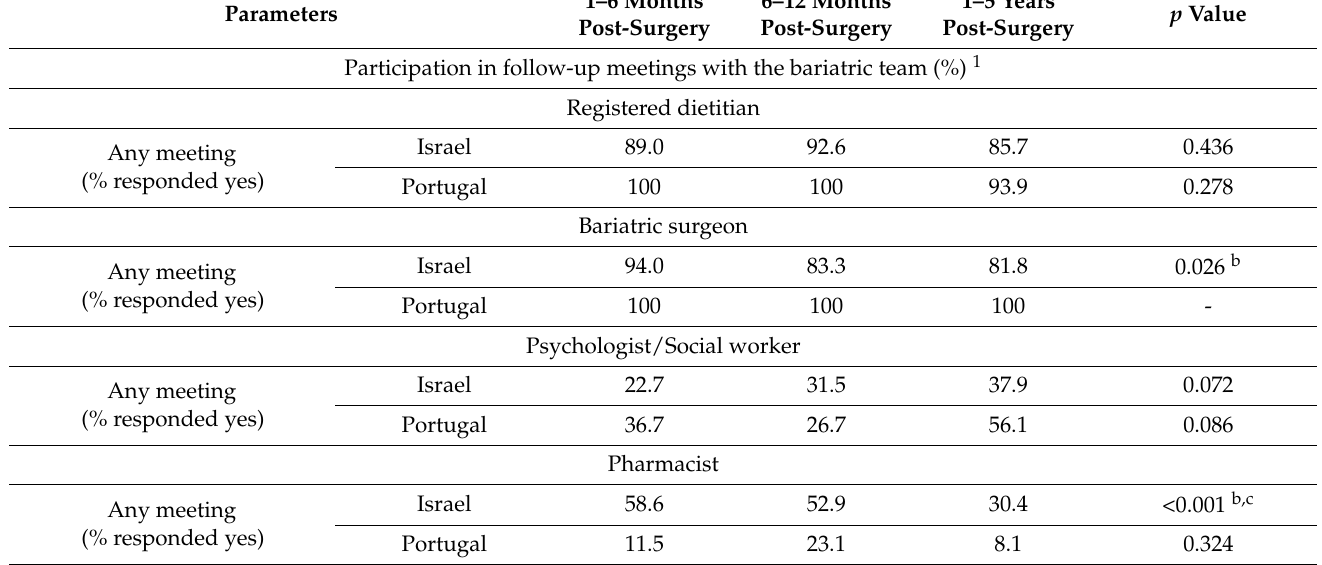
Table 4. Attendance to the follow-up regime grouped by time elapsed since surgery and by